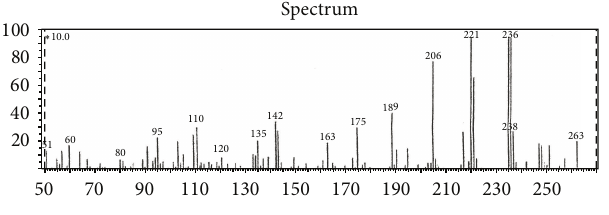
Figure 3: Mass spectrum of EEDB resin.